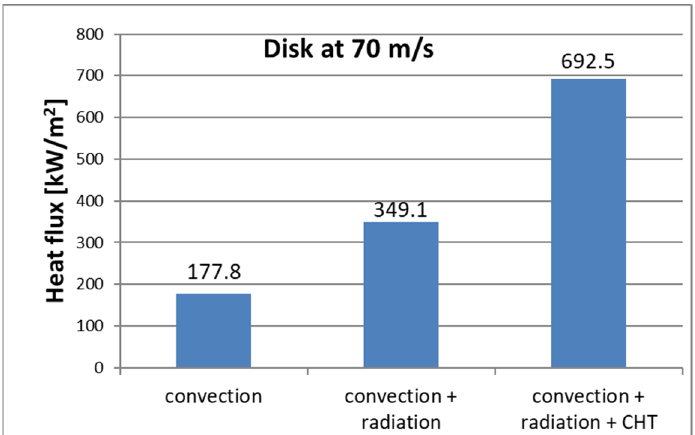
Figure 18. Heat flux removed from the main components at different car speeds—all coupled heat transfer mechanisms.